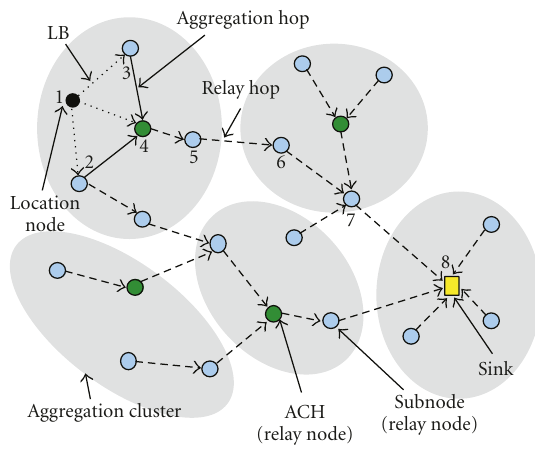
Figure 4: Relay network